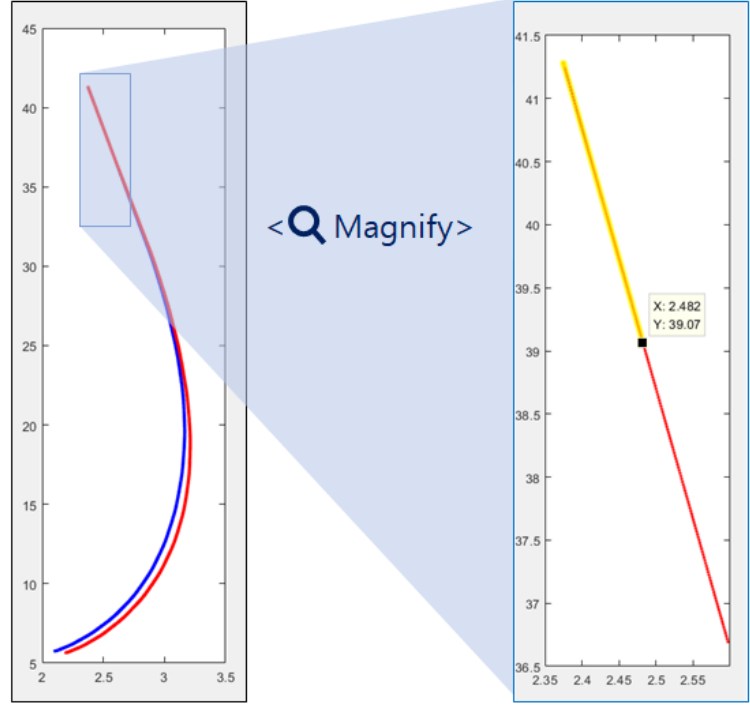
Figure 9. Trend-adjusted exponential smoothing (TAES) Figure 9. Trend ‐ adjusted exponential smoothing (TAES) graph. Table 1. TAES data.